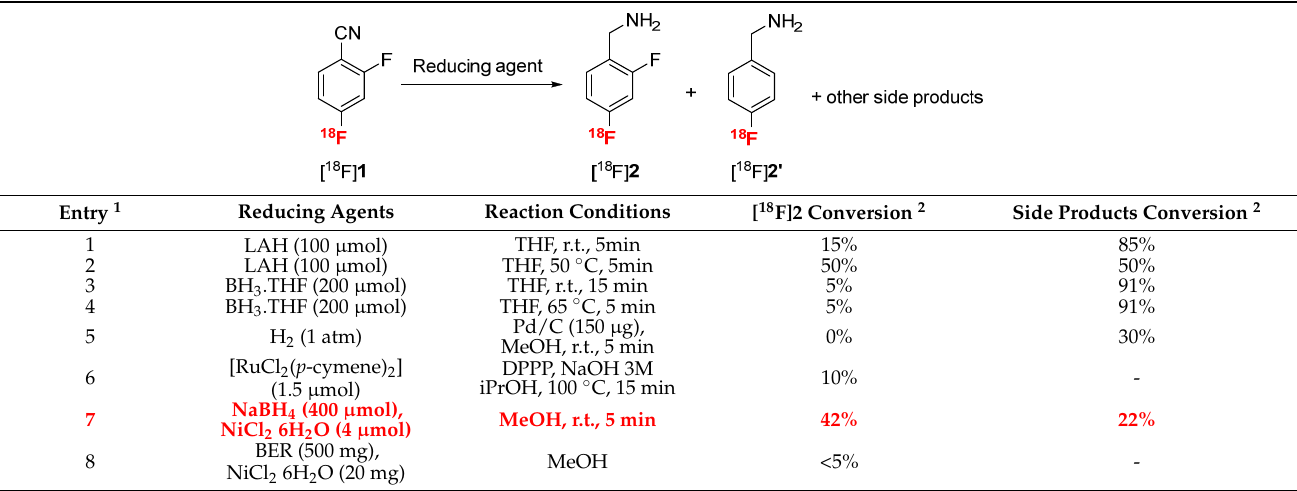
Table 2. Different reducing agents explored for the nitrile reduction of compound [ 18 F] 1 into [ 18 F] 2 .